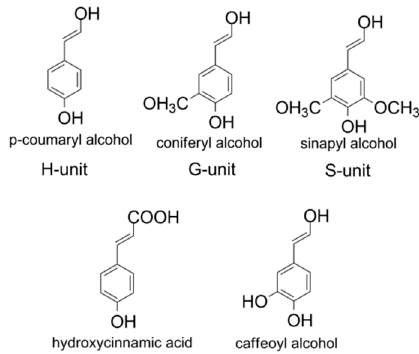
Figure 2. Main lignin monomer precursors produced by plants.